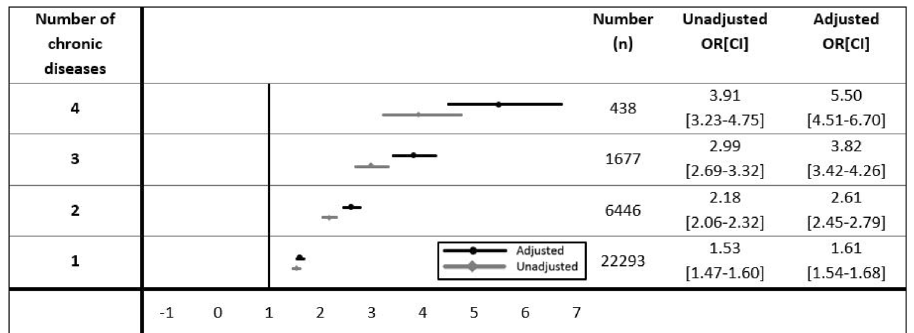
Figure 3. Unadjusted and adjusted odds ratios and 95% CI of experiencing severe fatigue for participants with one to four chronic diseases compared to participants without a chronic disease. Reference = participants without a chronic disease. Adjusted odds ratio corrected for age and